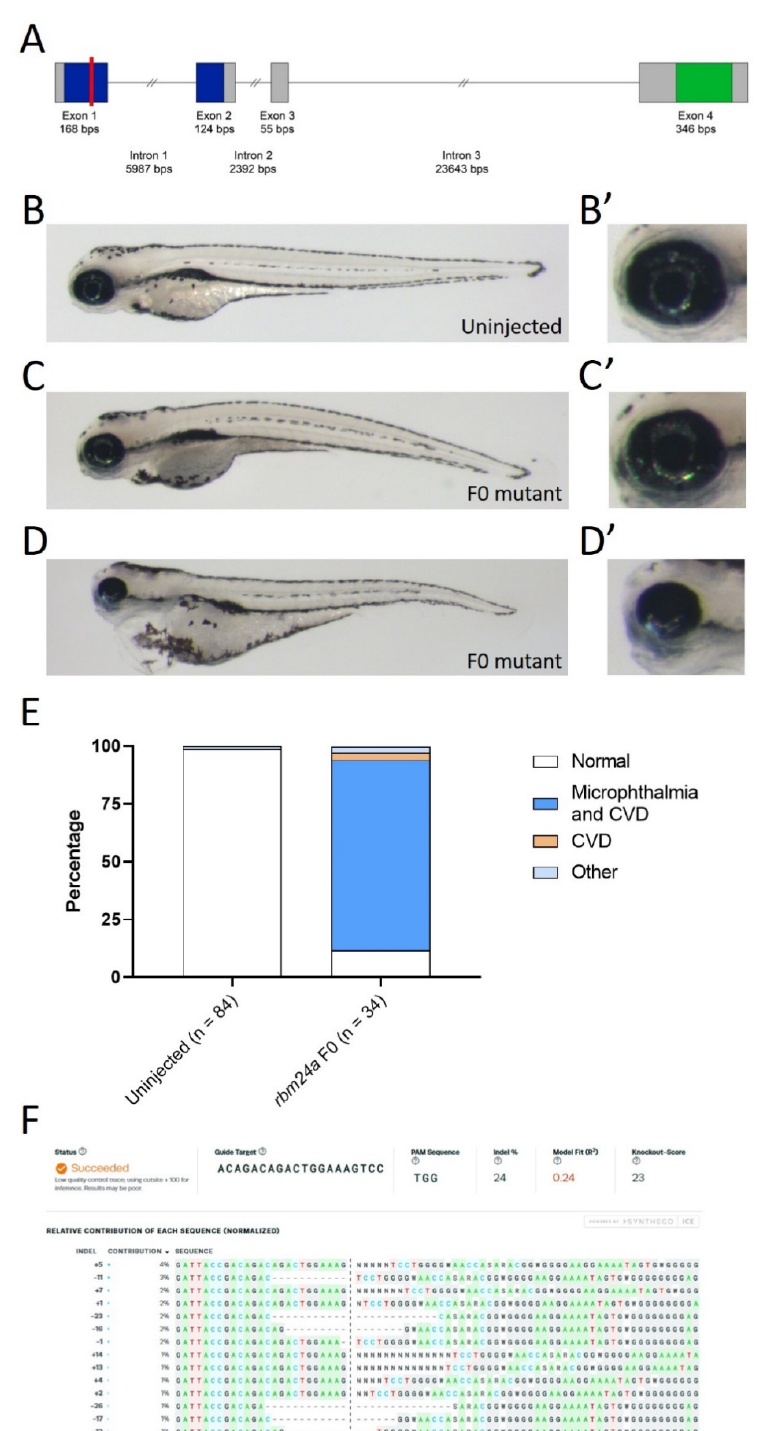
Figure 1. Mutation of rbm24a phenocopies morpholino knockdown. ( A ) Schematic for genetic structure of Rbm24a, with the RNA recognition motif (RRM) in blue and the Ala-rich region in green. The red line indicates the site of the Alt-R CRISPR/Cas0 mutation. ( B ) Uninjected control 4 dpf embryo with wild type morphology. ( B’ ) Detail of eye shown in B. ( C ) and ( D ) are Alt-R CRISPR/Cas9-injected embryos showing the variation of the phenotypes. ( C’ ) and ( D’ ) are detail of eyes found in C and D, respectively. ( E ) Graph of uninjected and CRISPR-injected F0 embryos. ( F ) Synthego ICE analysis of mutations found in F0 mutants. Indels are listed. Images taken at 33×.